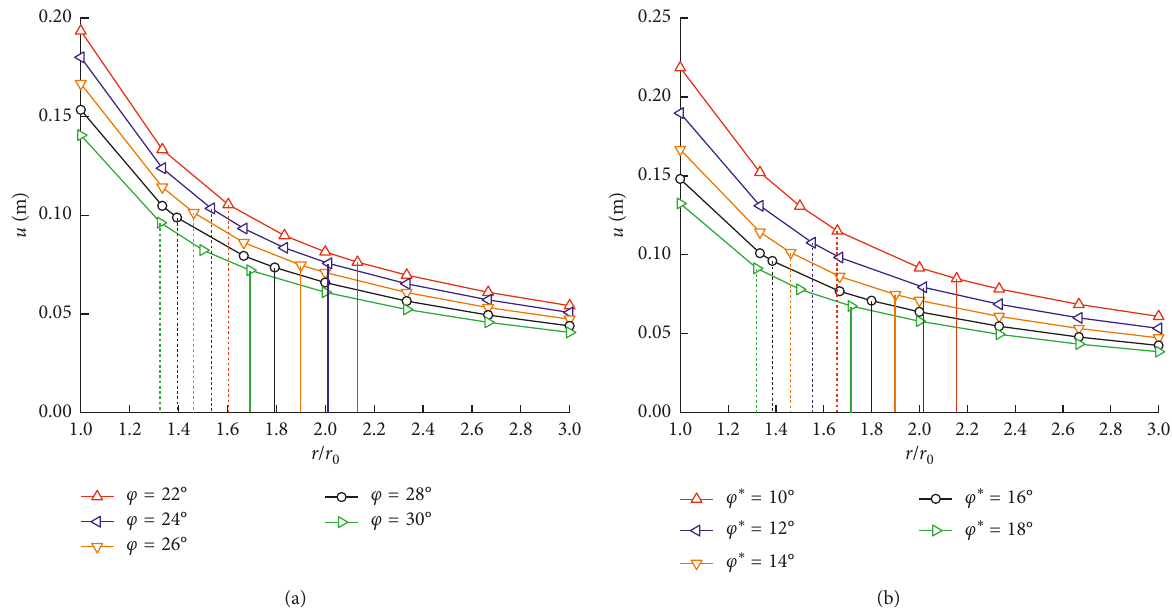
Figure 11: The influence of internal friction angle on plastic zone radius and displacements. (a) Strain-softening zone. (b) Broken